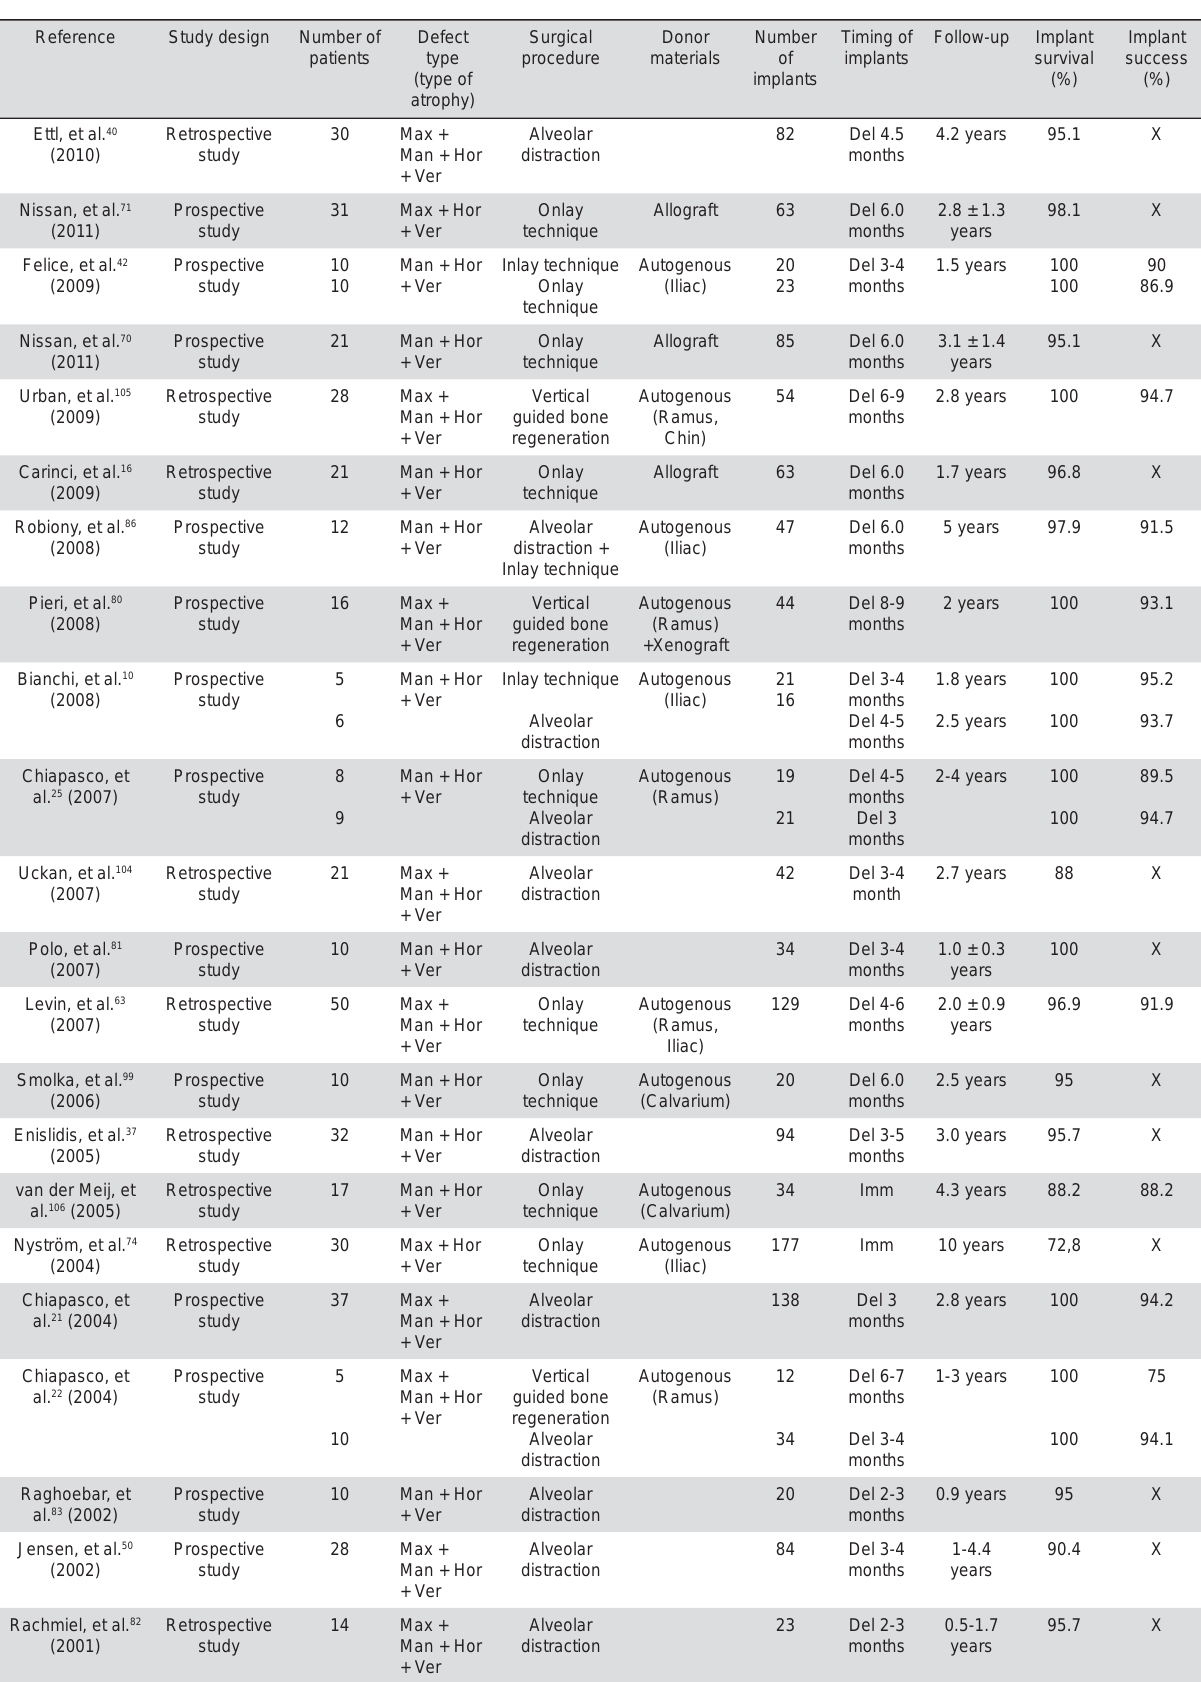
Long-term effects of vertical bone augmentation: a systematic